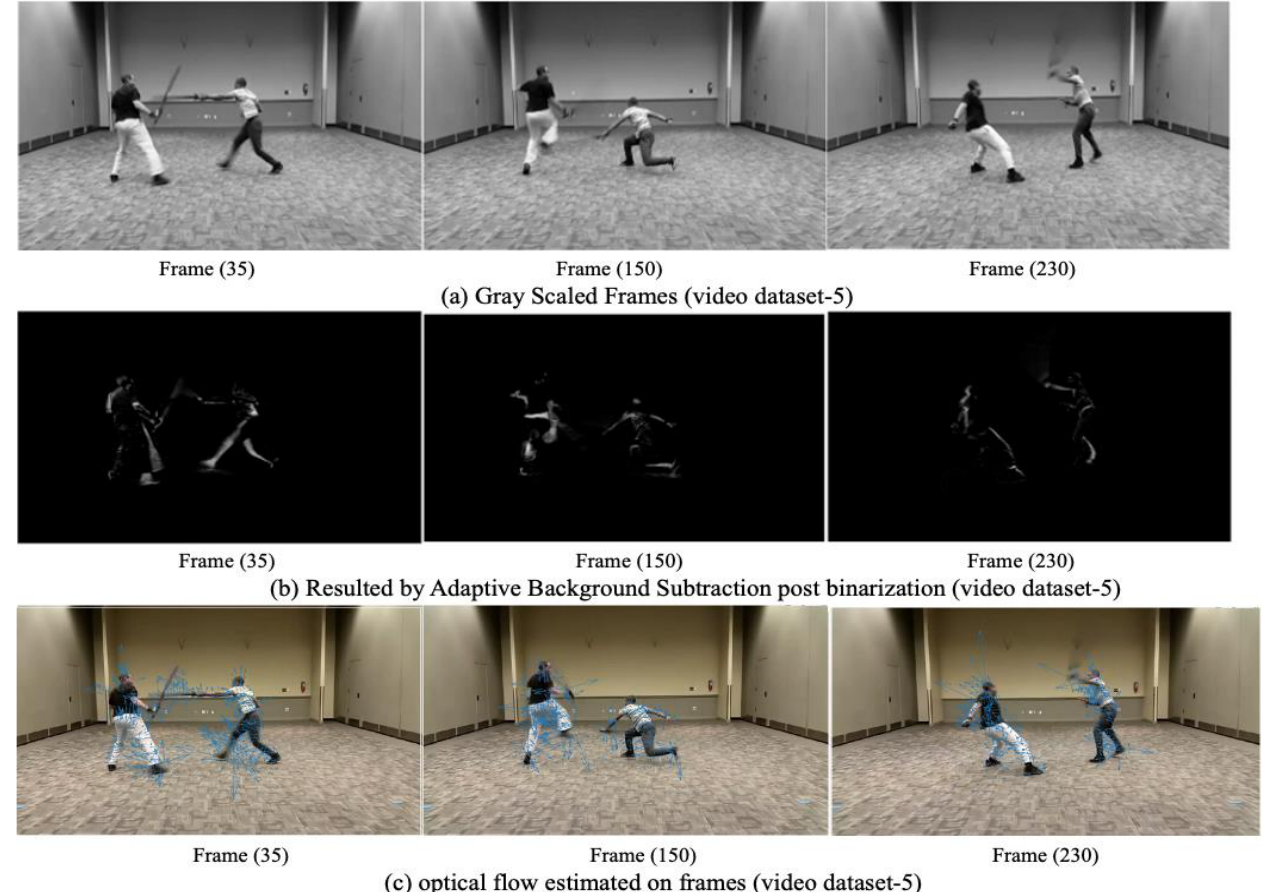
Figure 12. Simulation results from video dataset 5 by the proposed framework (( a ) extracted frames in grayscale, ( b ) foreground by adaptive background subtraction post-binarization and ( c ) optical flow).